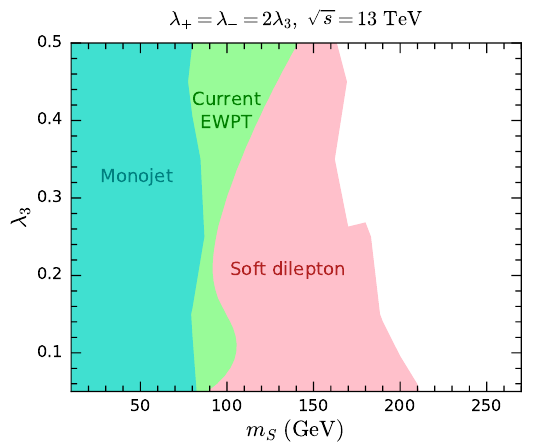
Figure 7 . Current constraints in the m S - λ 3 plane for λ + = λ − = 2 λ 3 . The pink (turquoise) region is excluded at 95% C.L. by the ATLAS soft-dilepton + jets + /E √ analysis [83]) at s = 13 TeV with a dataset of 36 . 1 fb − 1 . The light green region is excluded at